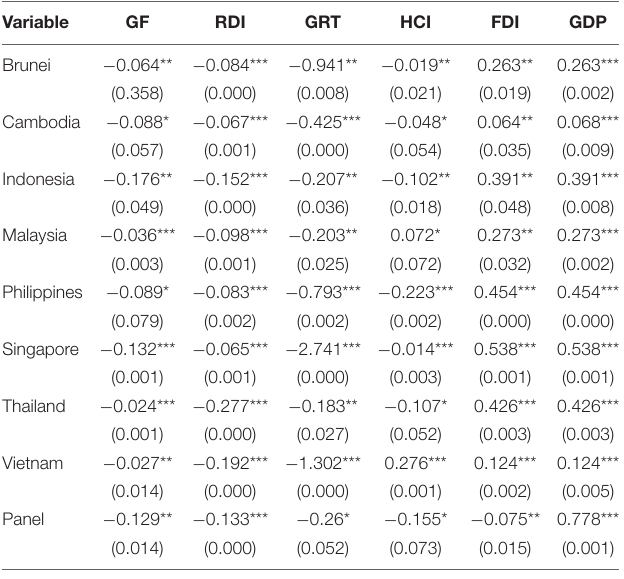
TABLE 6 | Results of long-run